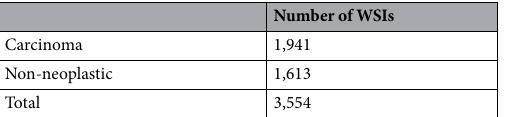
Table 2. Number of WSIs used in the training set from Kyushu Medical Centre.